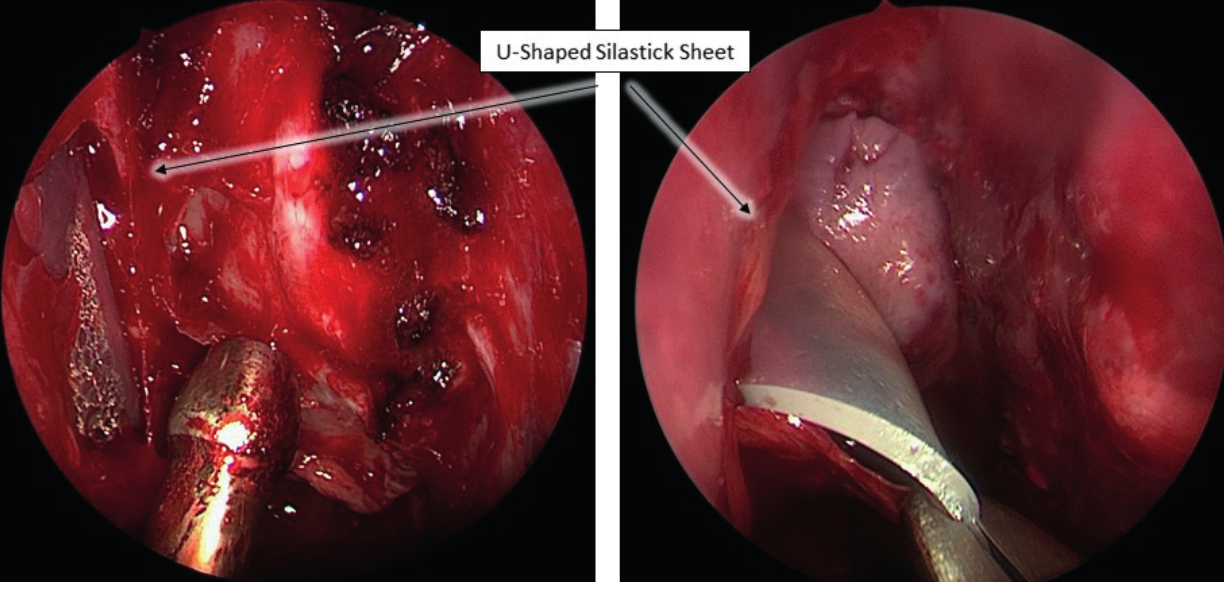
Figure 6. Intraoperative view of protective Silastic® sheet during transnasal tumour dissection (left) and transnasal removal of protective Silastic® sheet after completion of dissection